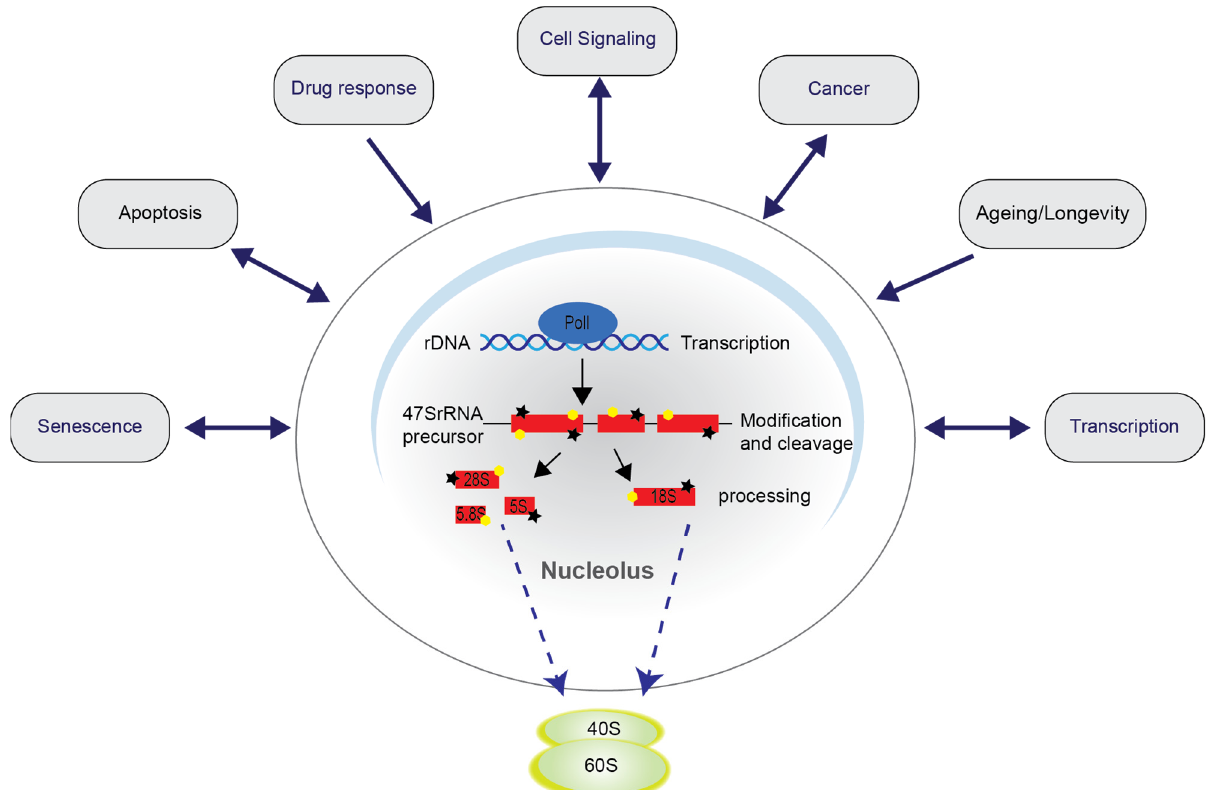
Figure 2. Schematic demonstrating the nucleolus as the hub of ribosome biogenesis and as a critical regulator of cellular homeostasis. Ribosome biogenesis starts with transcription of the 47S pre ribosomal RNA (rRNA) by the PolI preinitiation complex. The 47S transcript is cleaved, processed and packaged to eventually generate the 40S and 60S ribosomal sub-units. The function of the nucleolus is altered by a plethora of environmental and oncogenic stresses. This change in nucleolar function alters numerous cellular processes to alter phenotype and regulate homeostasis. Dashed lines represent movement within the cell. Black stars and yellow dots represent assembly factors. Arrows depict the direction of influence.